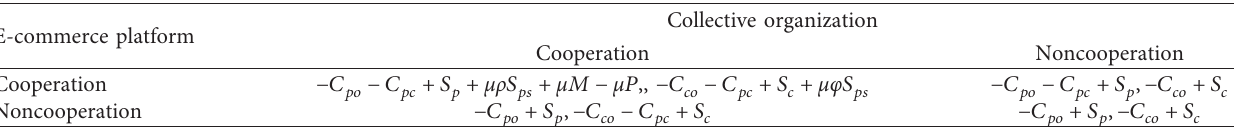
Table 2: The payment income matrix of E-commerce intellectual property social cogovernance with the collective